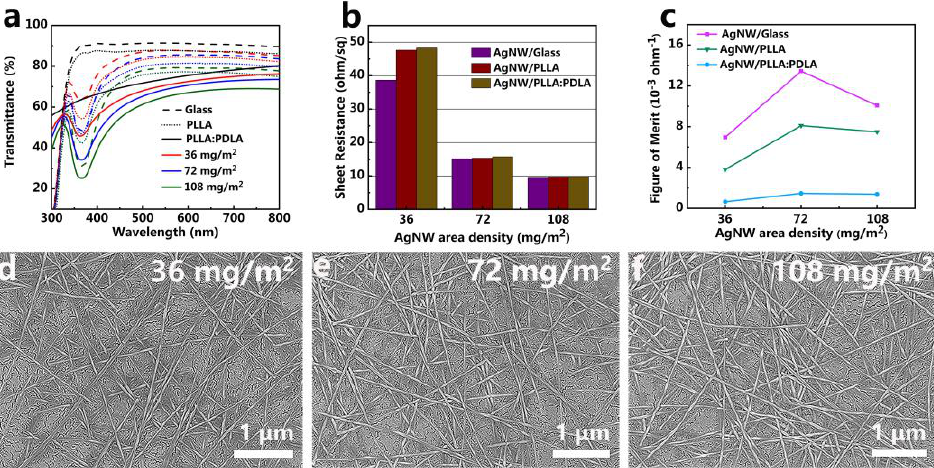
Figure 2. ( a ) Optical transmittance, ( b ) sheet resistance, and ( c ) figure of merit of the AgNW/Glass, AgNW/PLLA, and AgNW/PLLA:PDLA films with different AgNW area densities. ( d – f ) The corresponding SEM images of the surface of the AgNW/PLLA:PDLA film with different AgNW area densities. The same color lines mean the same AgNW area density in figure ( a ).